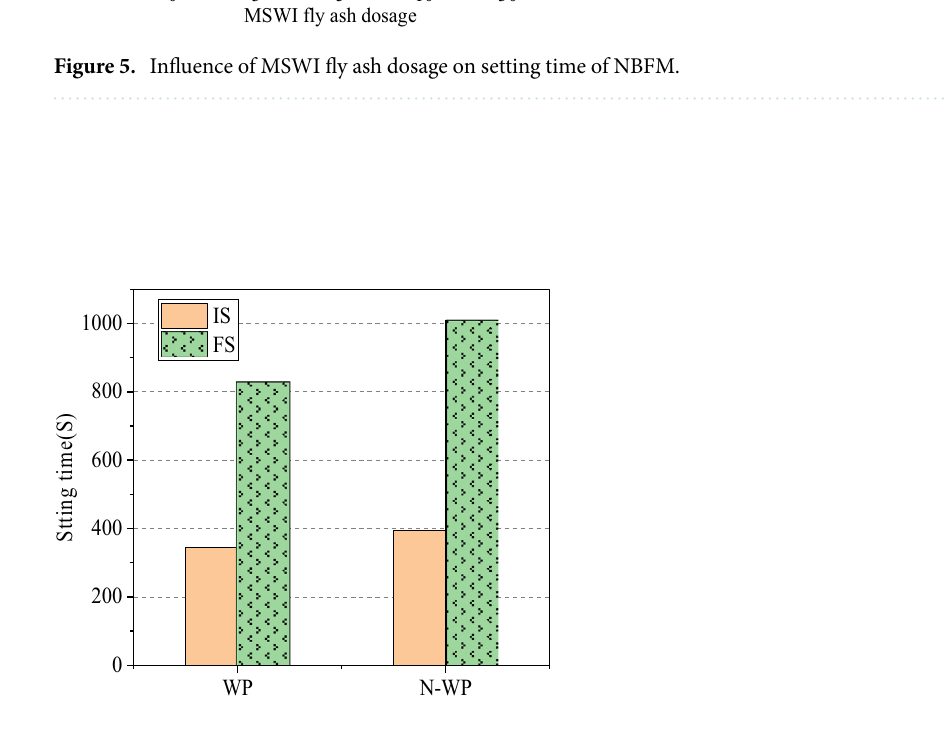
Figure 6. Influence of water washing pretreatment on condensation time of